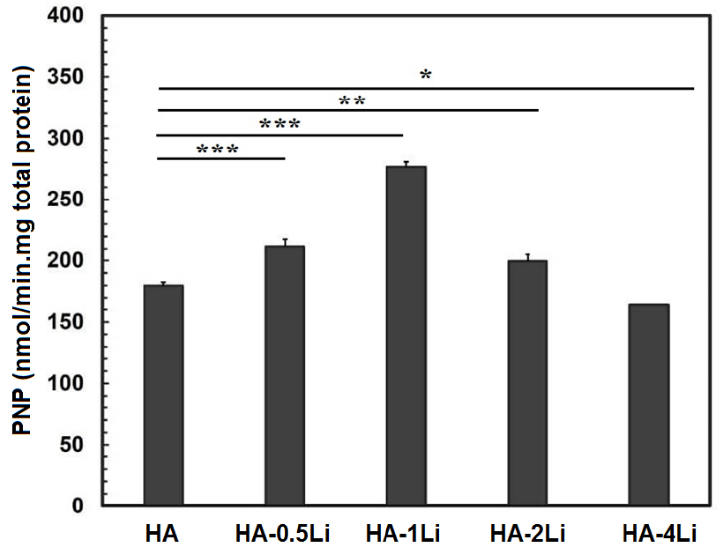
Figure 8. Alkaline phosphatase activity of cells on the HA and HA-Li scaffolds on day 7. (* for p < 0.05; ** for p < 0.01 and *** for p < 0.001).